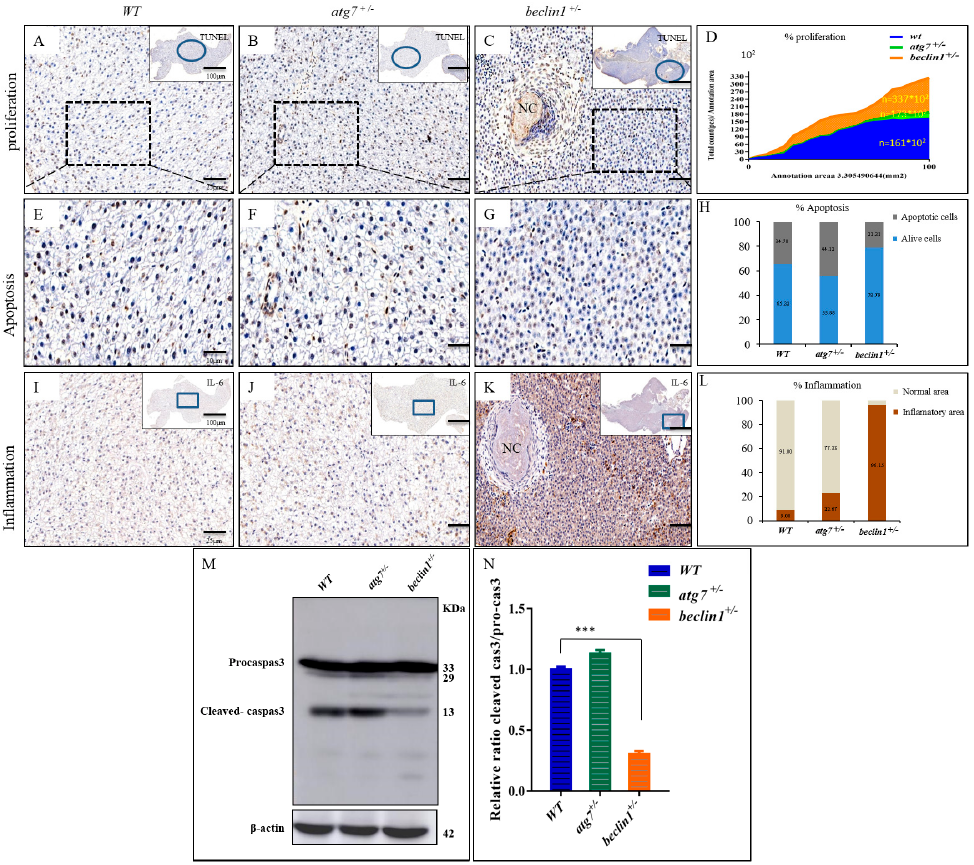
Figure 7. Beclin1 heterozygosity induces cellular proliferation in the hepatic tissue with lower apoptosis and a higher risk of inflammation. ( A – C ) In situ detection of apoptotic cells by TUNEL staining by higher magnification of the blue circles. Brown apoptotic cells around necrosis (black arrow) are shown. ( D ) The mean cell number per unit area was quantified by NIH Image J. The results were normalized from three independent slides of the same area. ( E – G ) Magnified views of the boxed regions in ( A – C ). ( H ) Percentage of apoptotic cells according to E-G. The data are shown as the statistical results of three independent experiments, three fields scored per condition. ( I – K ) Immunohistochemistry assay of liver tissues blocked against IL-6 showed in higher magnification of the blue frames. ( L ) The signals in ( I – K ) were scanned with a Pannoramic MIDI scanner to perform image quantification and analysis. Results were summarized from three independent replicates and data were expressed by mean. ( M – N ) Western blot analysis and quantified protein expression showed that cleaved-caspase3 were downregulated in the beclin1 +/ − livers in comparison with the WT or atg7 +/ − . β -actin was used as an internal control.